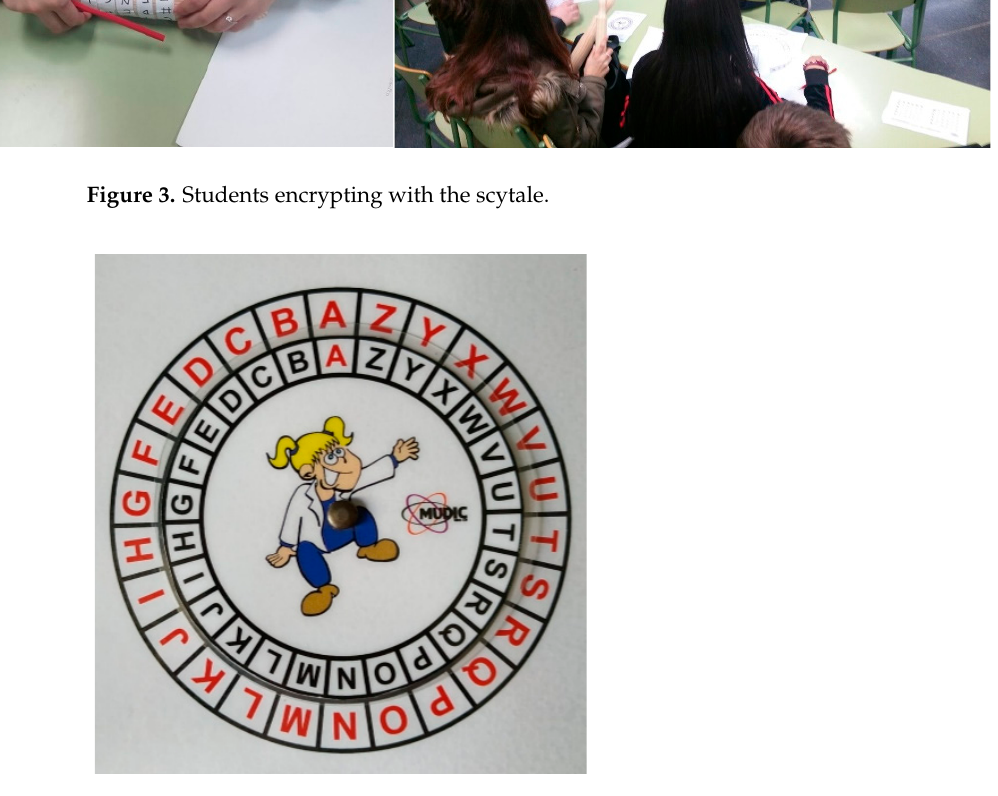
Figure 4. Caesar wheel designed at the MUDIC.